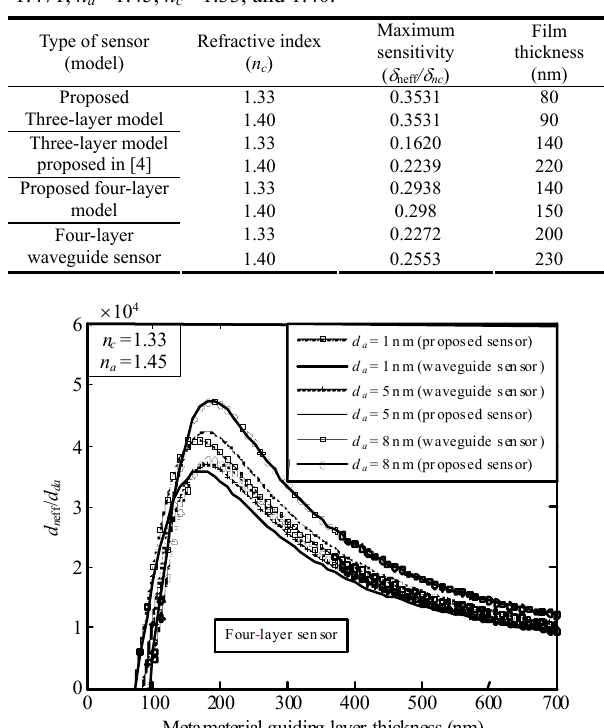
Table 1 Variation in cover layer sensitivity versus metamaterial guiding layer thickness. Other parameters are: n s = 1.471, n a = 1.45, n c = 1.33, and 1.40.